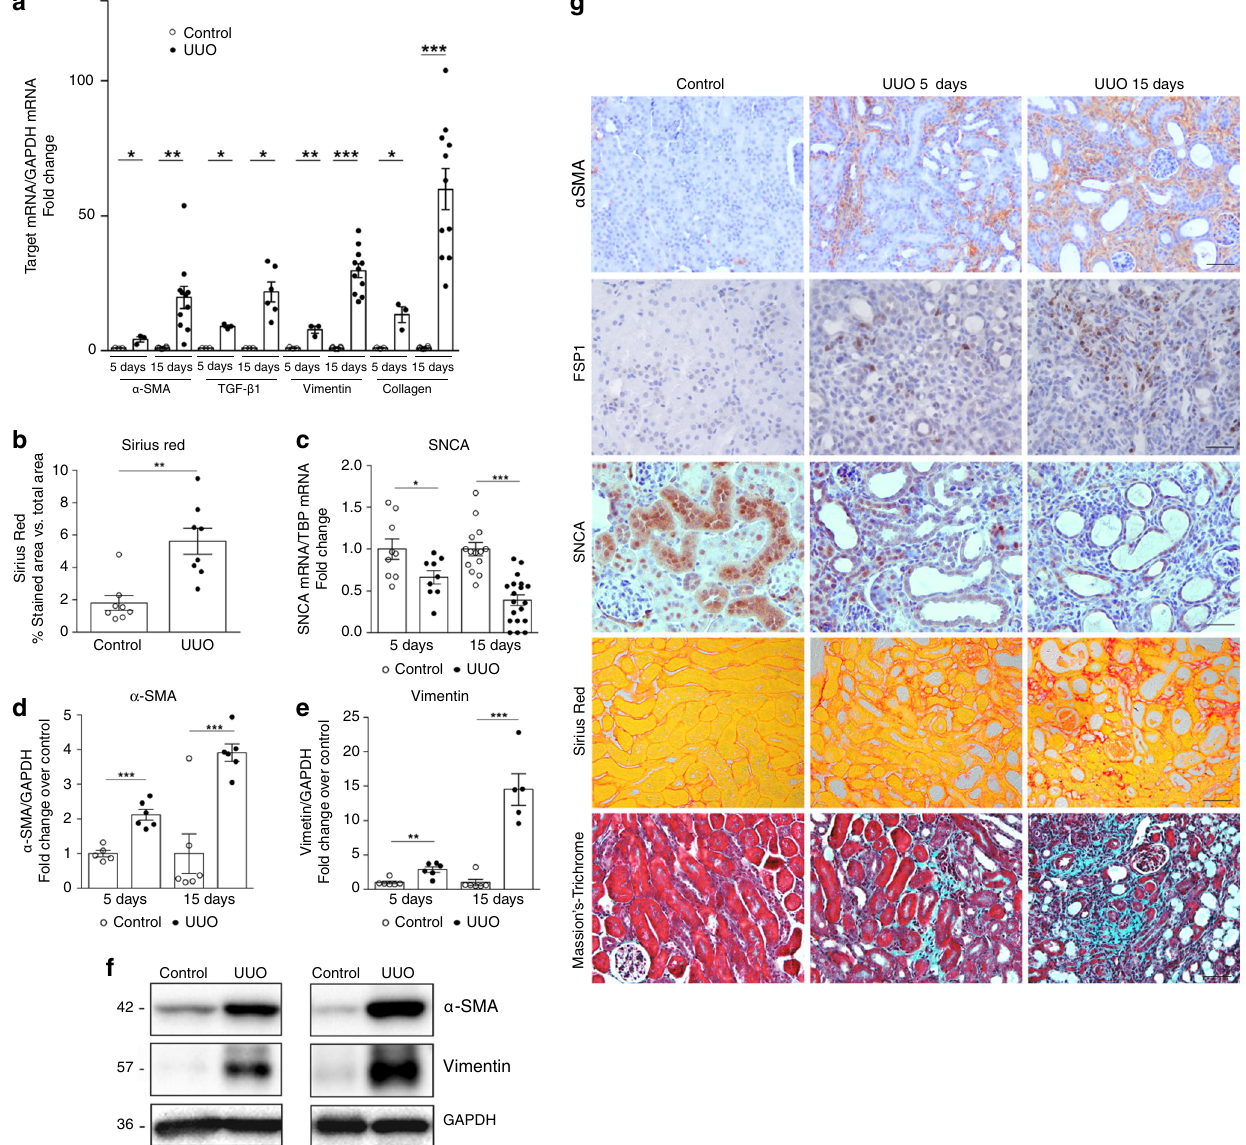
Fig. 4 SNCA decreases and fi brotic markers increase in obstructed mouse kidneys. a , c Total mRNA was extracted from kidneys and mRNA levels were determined by real-time qPCR. Relative mRNA levels were calculated and expressed as fold change over contralateral controls (value = 1.0) after normalizing for GAPDH or TBP. Data are presented as mean ± SEM ( a : n = 8-11 (UUO15) or 3 – 5 (UUO5) mice/group; c : n = 14 – 19 (UUO15) or n = 9 (UUO5) mice/group). b Quanti fi cation of collagen content after Sirius red staining was expressed as a positive stained area vs. total analyzed area. Data are presented as mean ± SEM ( n = 8 mice/group). f Representative Western blot analysis of α -SMA and vimentin in the kidneys of mice subjected to UUO. d , e Quantitative analysis by densitometry. Data were normalized to GAPDH and presented as mean ± SEM ( n = 8 mice/group) (fold change over contralateral control). g Representative micrographs illustrating the expression of α -SMA, FSP1 and SNCA in mouse kidneys after UUO. Scale bar represents 50 µ m. Masson´s trichrome and Sirius Red staining ’ s depict collagen deposition (blue or red, respectively) in kidneys affected by fi brosis. * p < 0.05, ** p < 0.01, *** p < 0.001 vs. contralateral control. The p -value by two-tailed Student ’ s -test. Source data are provided as a Source Data fi